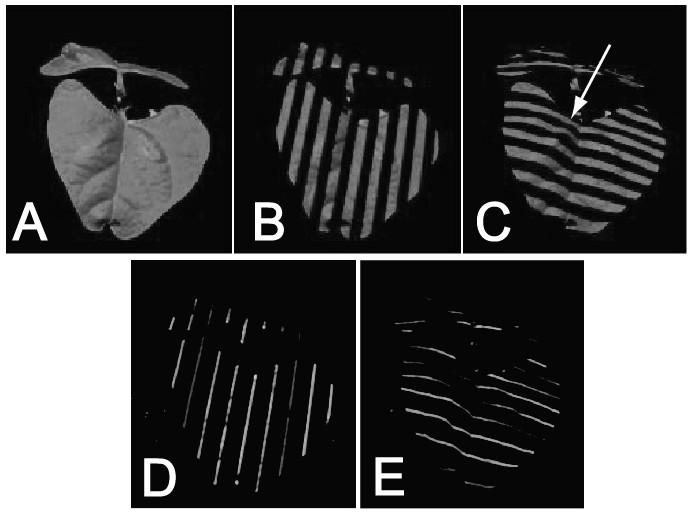
Figure 2. Coded light illumination of a Phaseolus vulgaris plant. Panel ( A ) shows full illumination. Panel ( B ) and ( C ) show pictures extracted from the Gray code illumination pattern, panel ( D ) and ( E ) show picture extracted from the Phase Shift Sequence illumination patterns. In total 48 pictures were taken in coded light plus a picture in full light. Since the pictures are taken with exactly the same settings, they can be overlapped. Each pixel will be characterized by a sequence of null and ones (dark and illuminated) that identifies individually the light beam that was shined on the captured